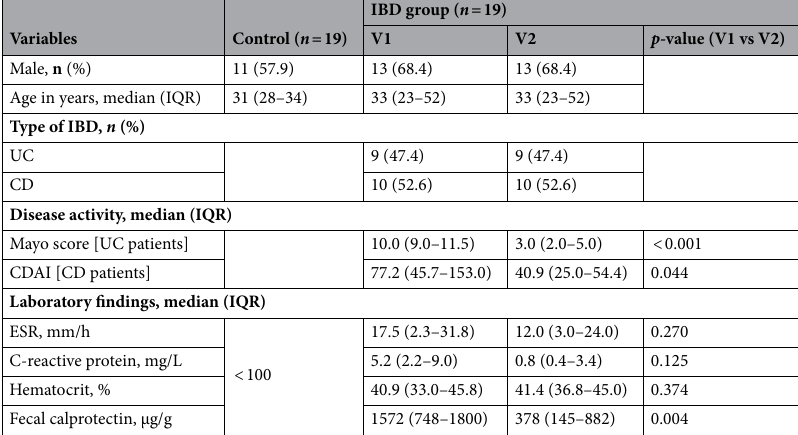
Table 1. Baseline characteristics of the control and inflammatory bowel disease (IBD) groups before anti- TNF-α therapy (V1), and characteristics of the IBD group 3 months after anti-TNF-α therapy (V2). The independent Student’s t-test (or Mann–Whitney test) was used for continuous variables and the χ 2 test (or Fisher’s exact test) was used for categorical variables. CD Crohn’s disease, CDAI CD activity index, ESR erythrocyte sedimentation rate, IQR interquartile range, TNF tumor necrosis factor, UC ulcerative